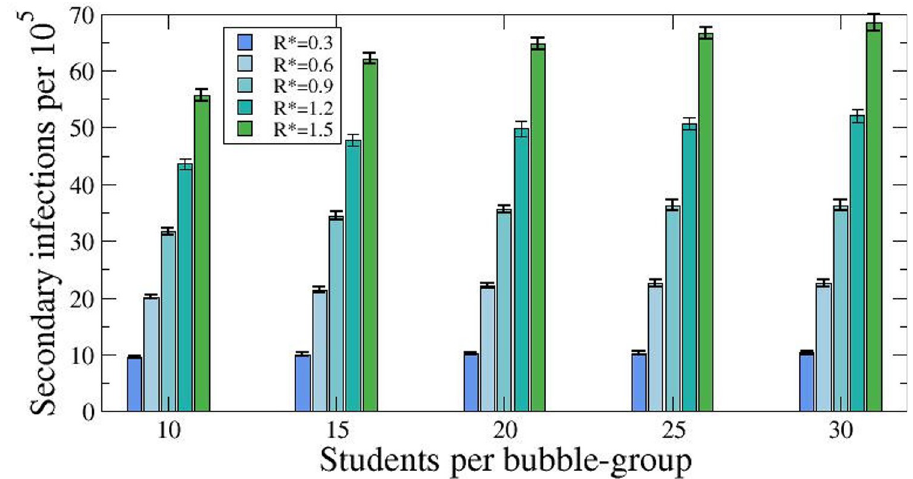
Fig 1. Variation of the number of secondary infections per 10,000 students according to the size of bubble groups. Number of secondary cases obtained from the numerical simulations by varying values of R � and numbers of scholars forming the bubble groups after the detection of the first infected student. Simulations done keeping A 14 = 250 cases per 100,000 inhabitants, and the total number of students fixed to 1,436,680 (A 14 = Cumulative incidence over 14